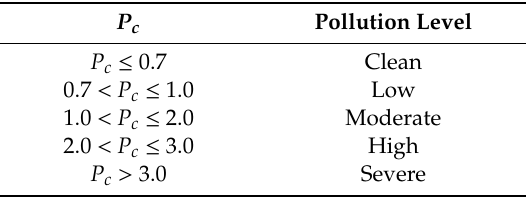
Table 2. Grading of soil heavy metal pollution.